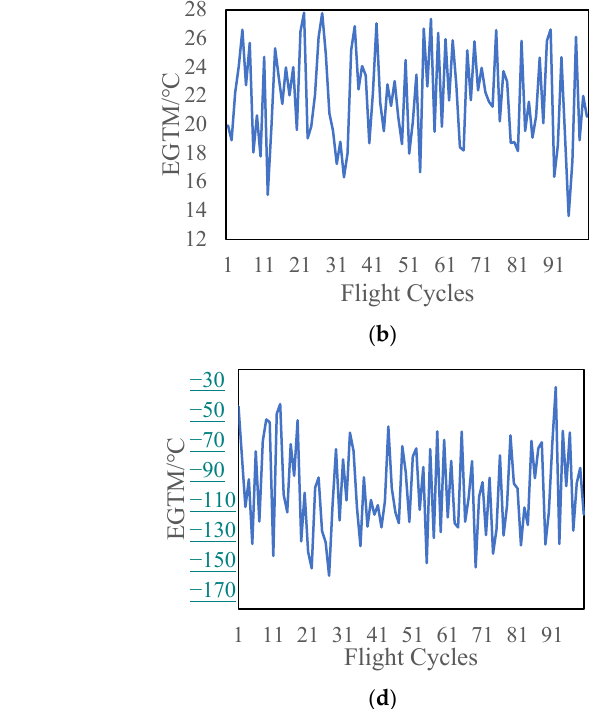
Figure 9. The fault data involved in this paper. ( a ) EGTM data for compressor failure; ( b ) EGTM data for fan failure; ( c ) EGTM data for high pressure turbine failure; ( d ) EGTM data for low pressure turbine failure.